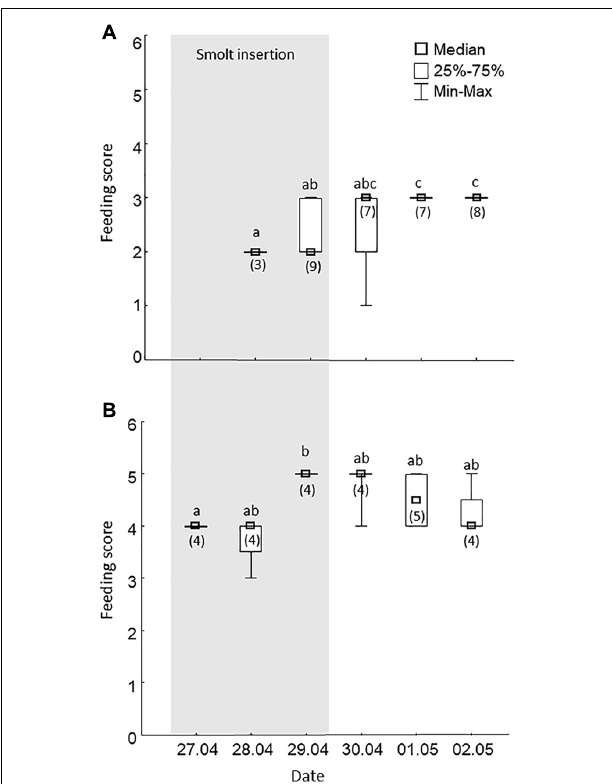
FIGURE 3 | Behavioral response to feeding in Atlantic salmon reared in two raceways in a commercial RAS for slaughter size salmon during a 3-days smolt insertion period (April 27–29) and the three following days (30 April–2 May). Smolts were inserted in raceway 1 (A) . This raceway was empty before smolt insertion. Salmon that were established in the system were kept in raceway 2 (B) . A feed score of four corresponds to all pellets eaten without observations of aggressive behavior. The feeding score under four score corresponds to that not all pellets are eaten, and the feeding score above four corresponds to that all pellets are eaten and aggressive behavior is observed. More details about the feeding score are shown in section “Materials and Methods.” Numbers within parenthesis denotes the number of daily observations. Different lowercase letters indicate significant differences ( p = 0.05) between daily feeding scores within a raceway. RAS, recirculating aquaculture